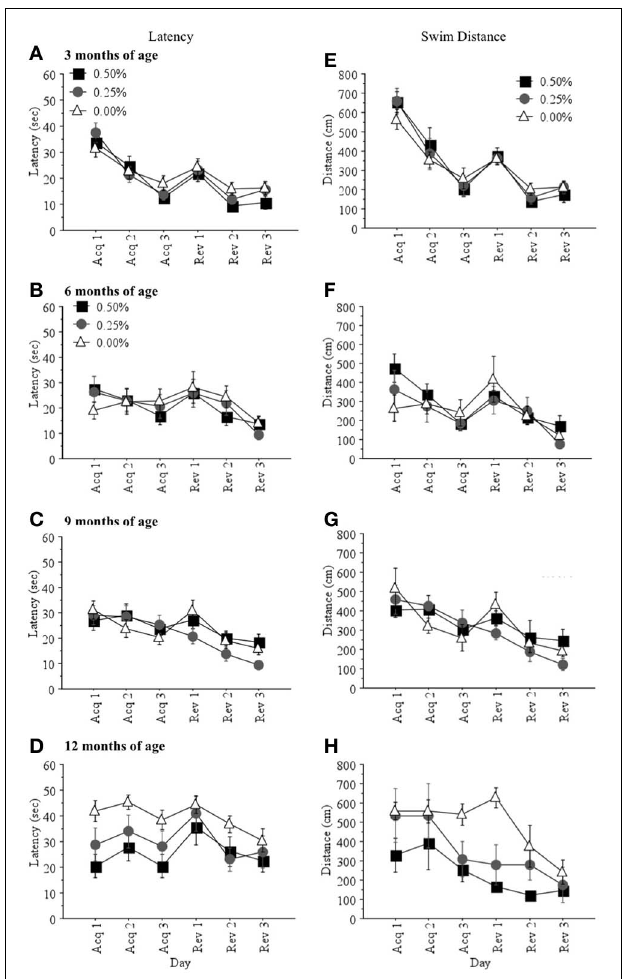
FIGURE 2 | Mean ( ± S.E.M.) percentage of time spent in the correct (quadrant) and number of annulus crossings in the probe trial in the Morris water maze, with 25% indicating chance, for mice receiving 0.50, 0.25, and 0.00% Timoptic-XE at 3 (A,E), 6 (B,F), 9 (C,G), and 12 (D, H) months of age. Dotted line = 25% (chance). Different letters indicate significant differences between groups ( p < 0 .